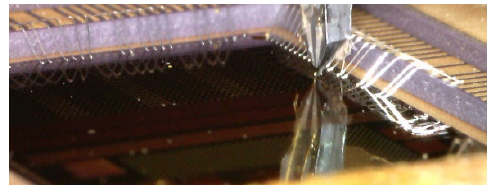
Figure 3. Failing sample under the GMR sensor.